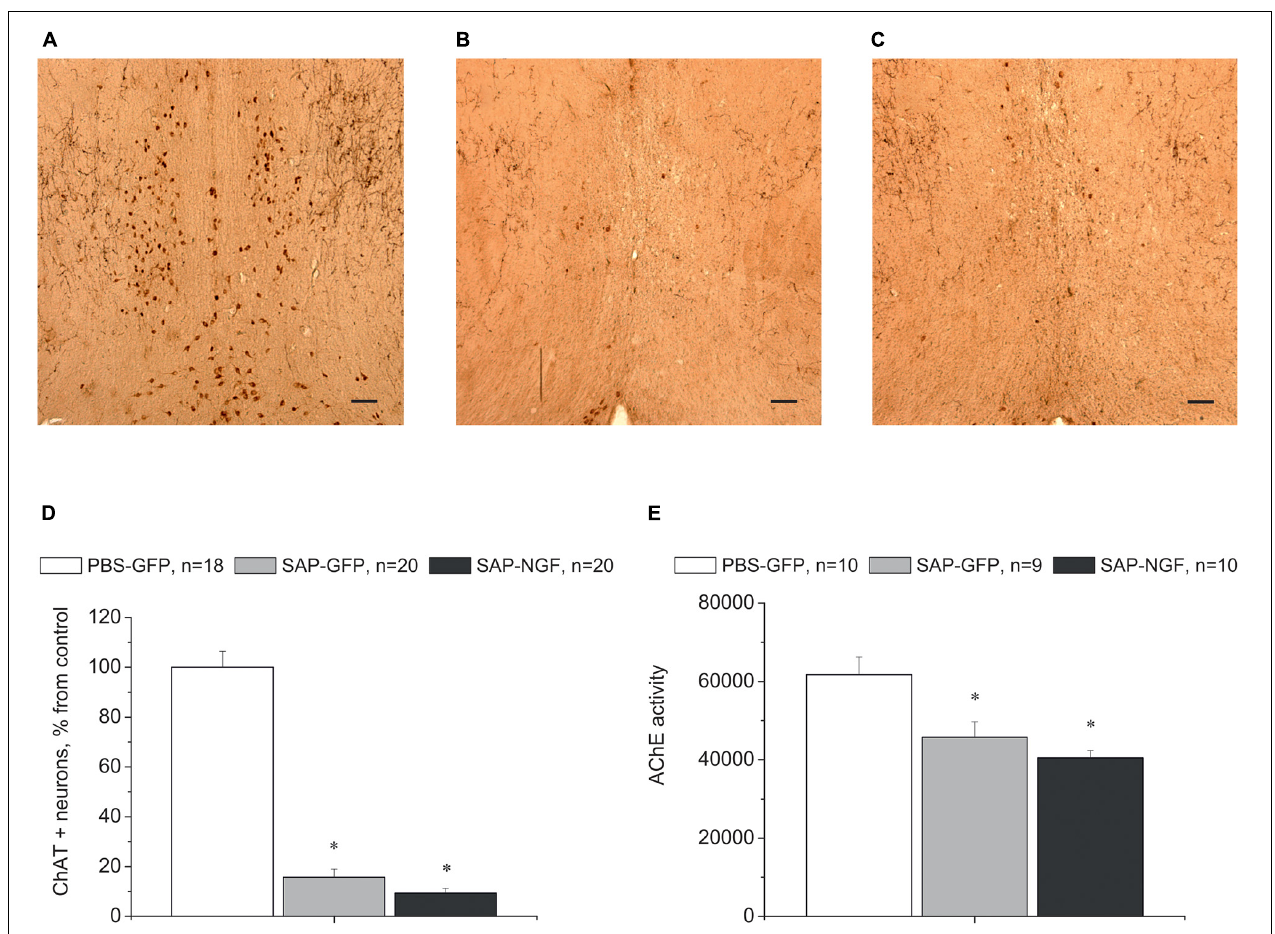
FIGURE 3 | (A–C) Show immunostaining of ChAT in the medial septal area of rats treated with PBS (A) , 192IgG-saporin (B) , or 192IgG-saporin and NGF-carrying virus (SAP-NGF) (C) . (D) Shows the number of ChAT-positive neurons counted in the medial septum area. Bar, 200 µ m. (E) Demonstrates acetylcholinesterase activity in rat hippocampi injected with PBS (PBS-GFP, n = 10), 192IgG-saporin (SAP-GFP, n = 9), and with 192IgG-saporin and NGF-carrying virus (SAP-NGF, n = 10) 1.5 month postinjection. Each point represents mean ± SEM. ∗ Significant differences against the saline group, p <